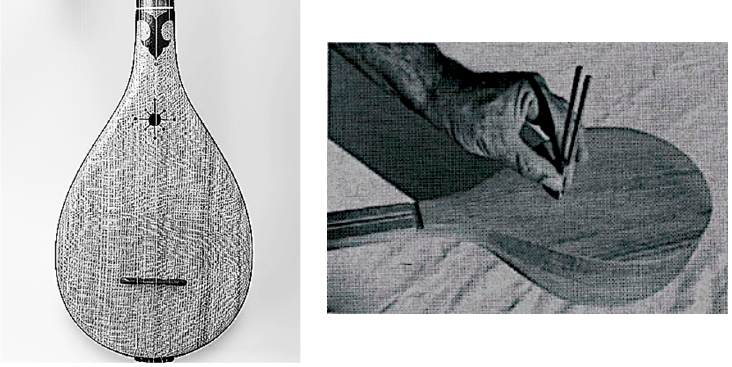
Figure 7. Empirical sound ‐ hole design and development for setars.